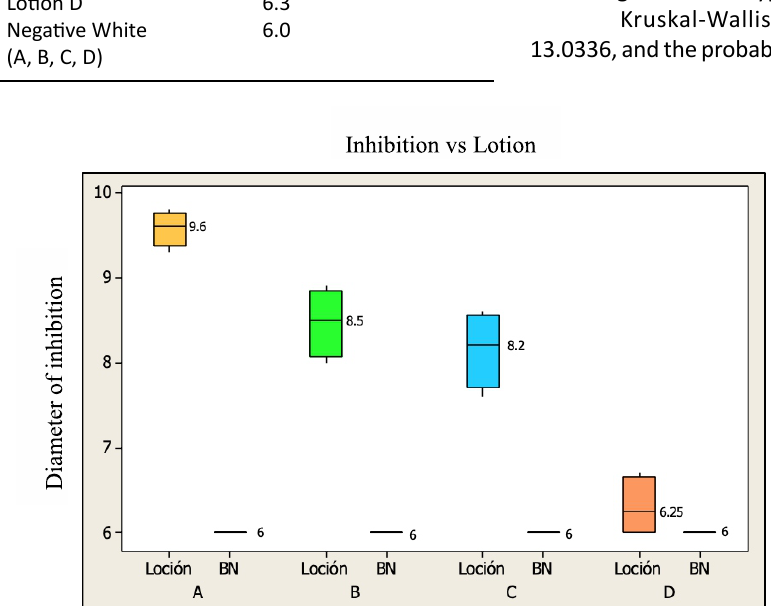
Fig. 3 . Box plot of inhibition diameter vs experimental lotions, made in MINITAB